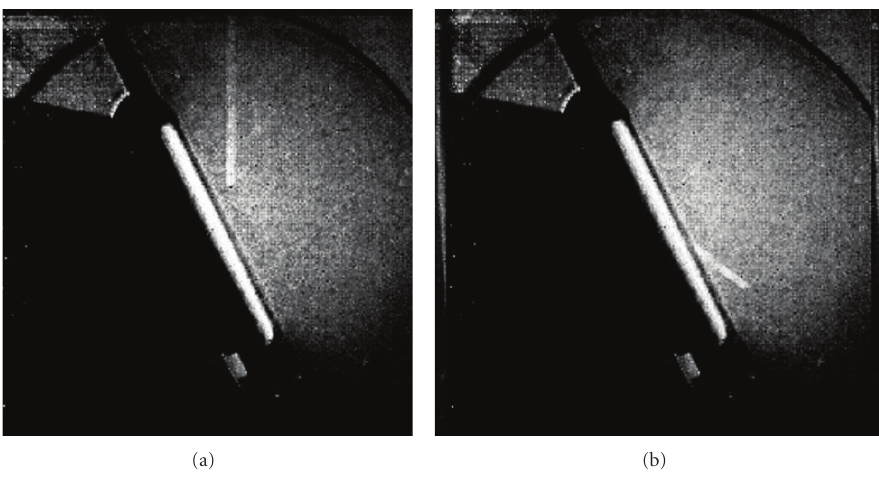
Figure 3: High-speed photography images.